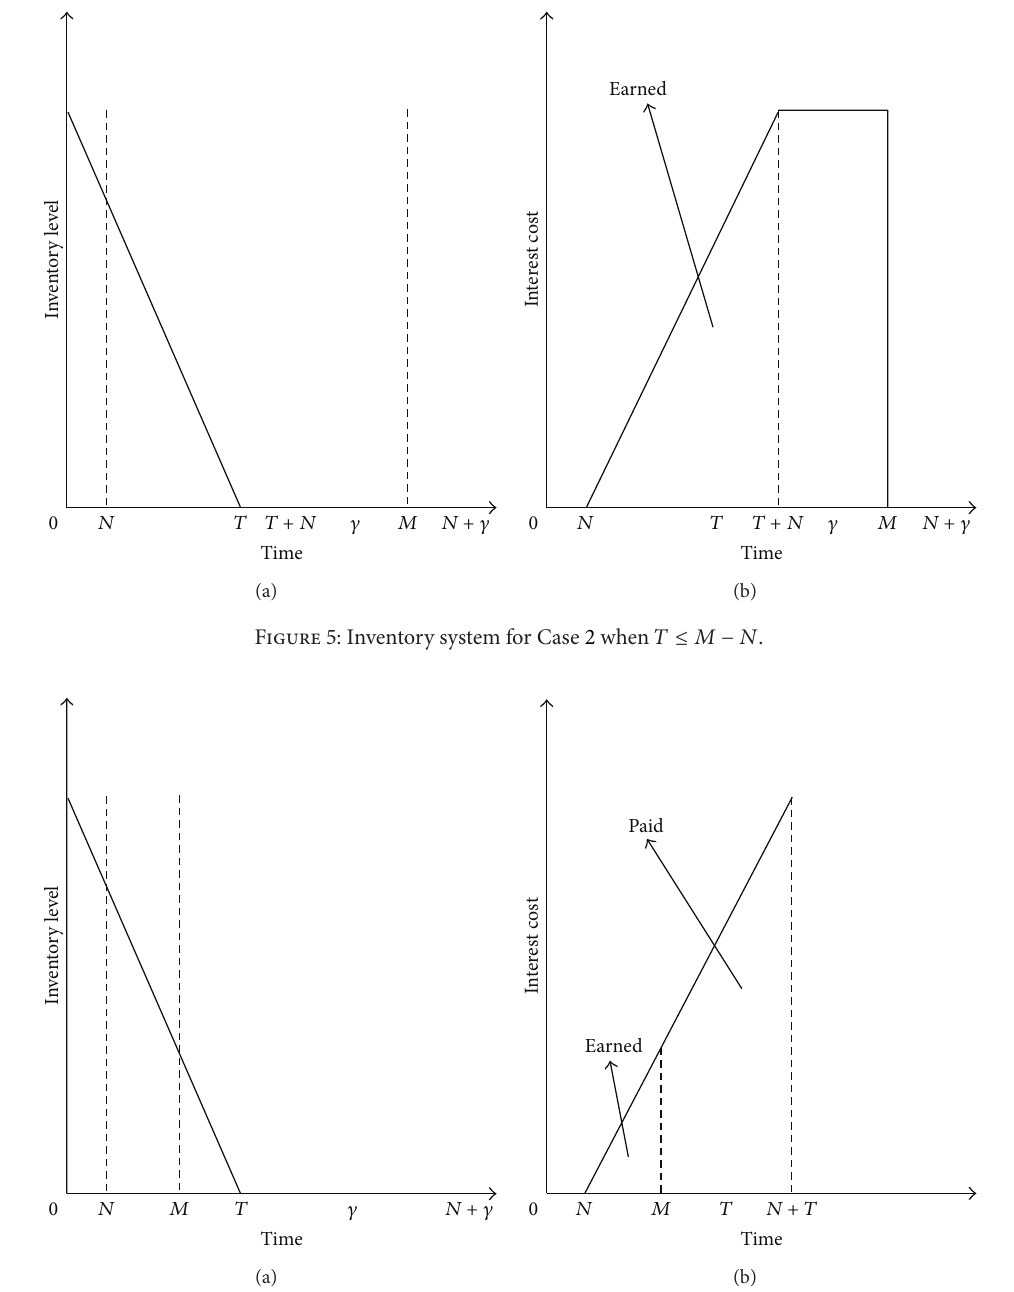
Figure 6: Inventory system for Case 2 when 𝑀 − 𝑁 ≤ 𝑇 ≤ 𝛾